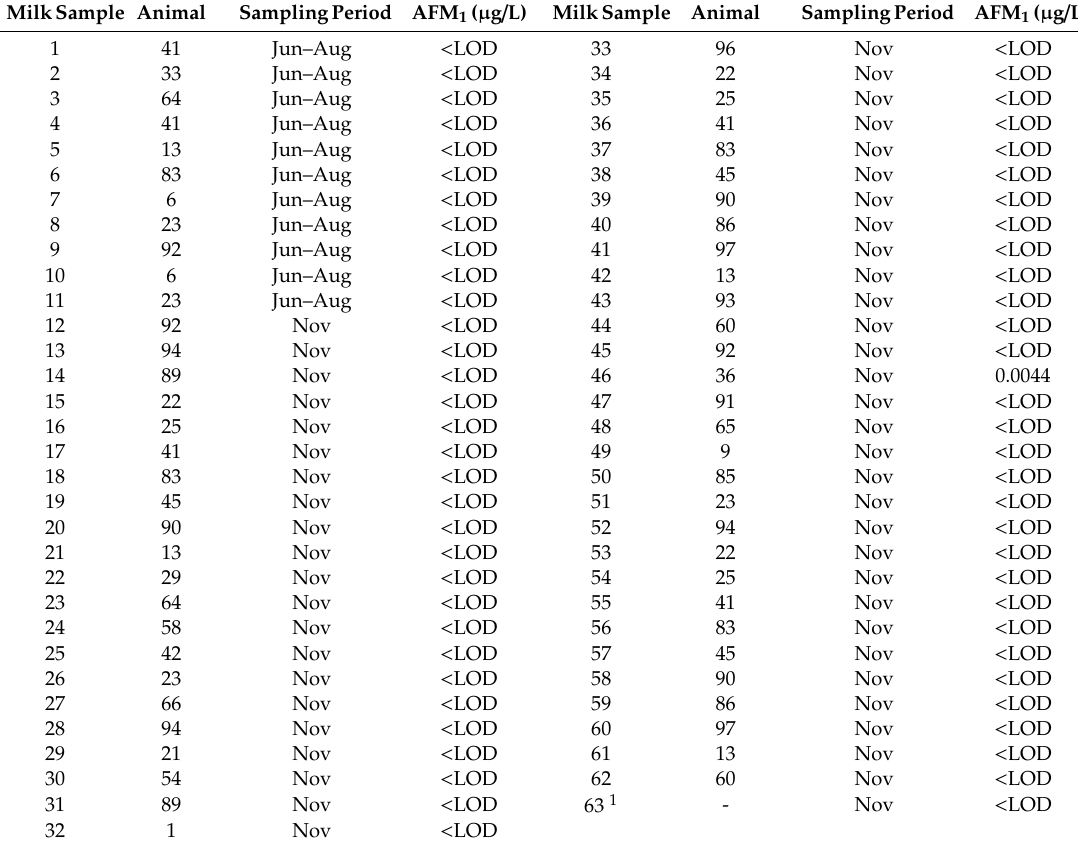
Table 2. Milk samples and AFM 1